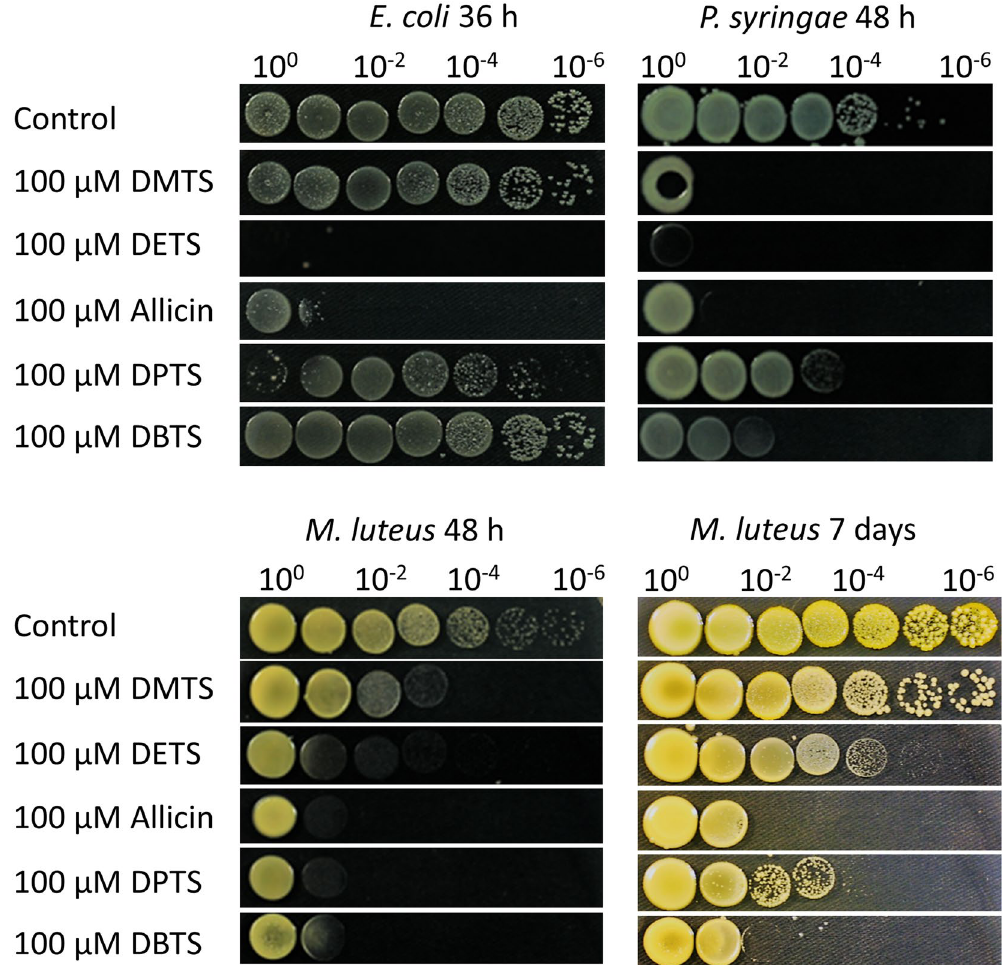
Figure 7. Drop test illustrating the relative inhibitory activities of the thiosulfinates incorporated into growth medium at 100 µ M on E. coli, P. syringae 4612 and M. luteus , respectively. M. luteus is shown after 48 h and 7 days of